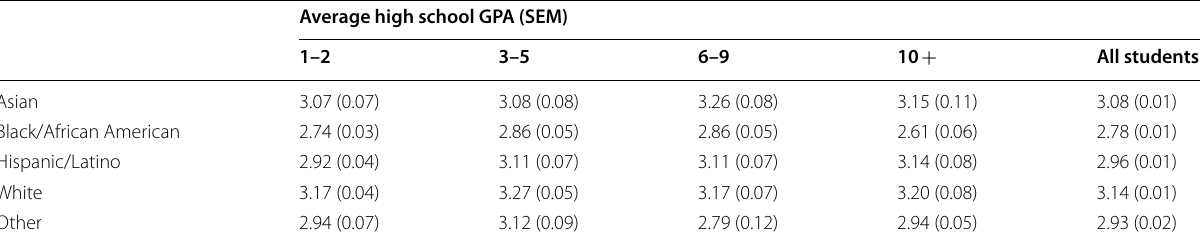
Numbers in parentheses are standard errors of the means